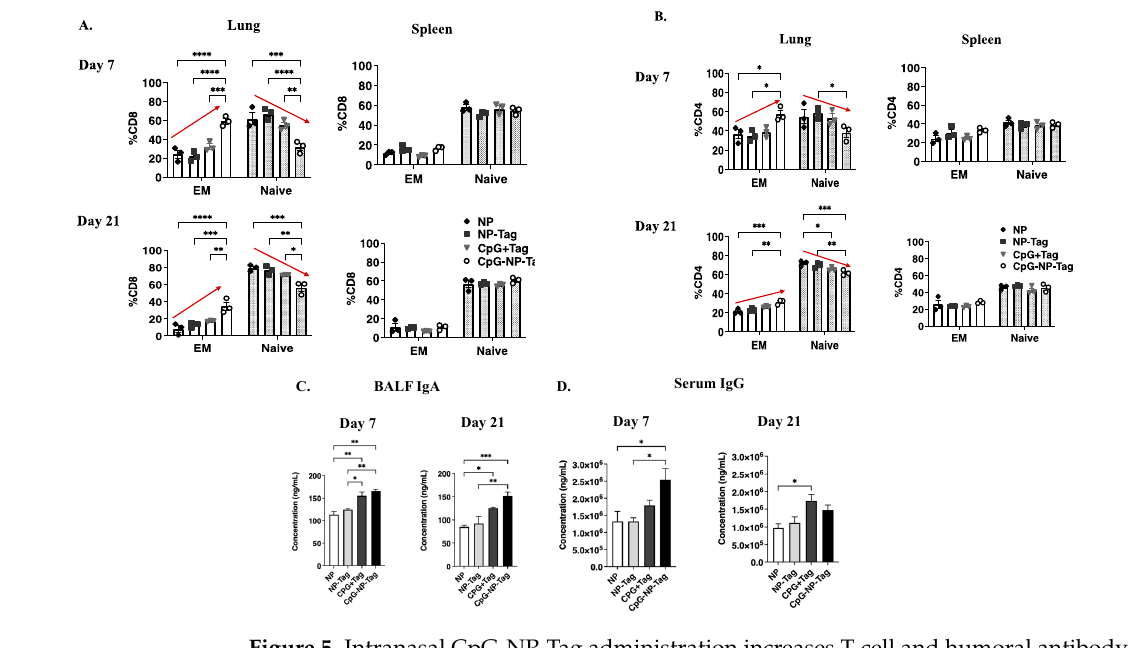
Figure 5. Intranasal CpG-NP-Tag administration increases T-cell and humoral antibody-mediated immune responses in lower respiratory of BALB/C mice. ( A , B ) Proportions of T EM (CD44 + and CD62L - ) and naïve (CD44 - and CD62L + ) cells among CD8 + ( A ) and CD4 + ( B ) T cells in lungs and spleen day 7 and day 21 post immunization. Two-way ANOVA followed by Tukey’s multiple comparison test. ( C , D ) Concentrations of BALF IgA ( C ) and serum IgG ( D ) day 7 and 21 post immunization. One-way ANOVA followed by Tukey’s multiple comparison test. **** p < 0.0001, *** p < 0.001, ** p < 0.01, * p < 0.05.